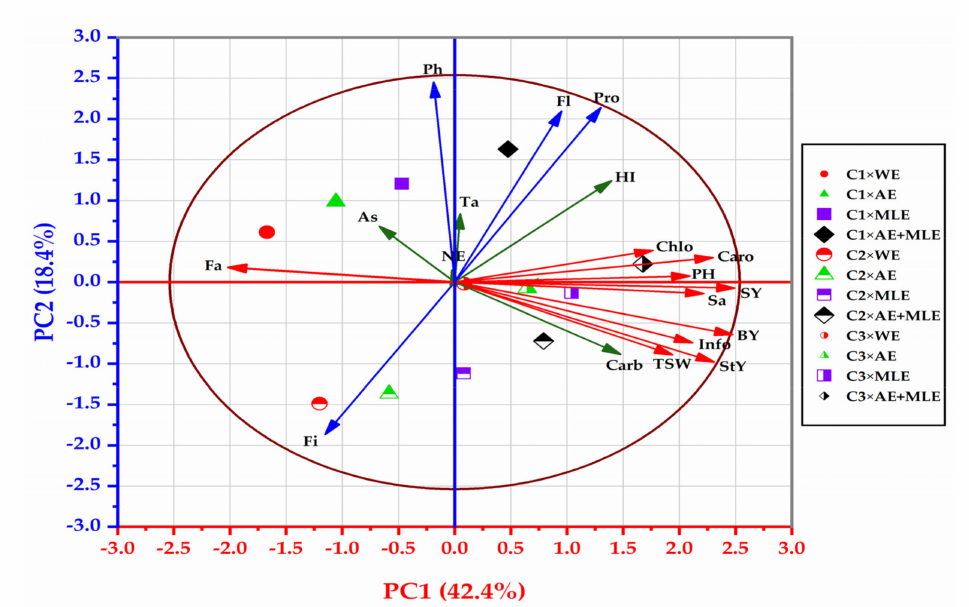
Figure 11. Biplot of the principal component analysis (PCA) of Chenopodium quinoa foliar sprayed with Azolla (AE), moring (MLE) extracts, and their combination. The first and second principal components (PC1 and PC2) presented 60.8%. The vectors show the studied traits, and the colored shapes explained various